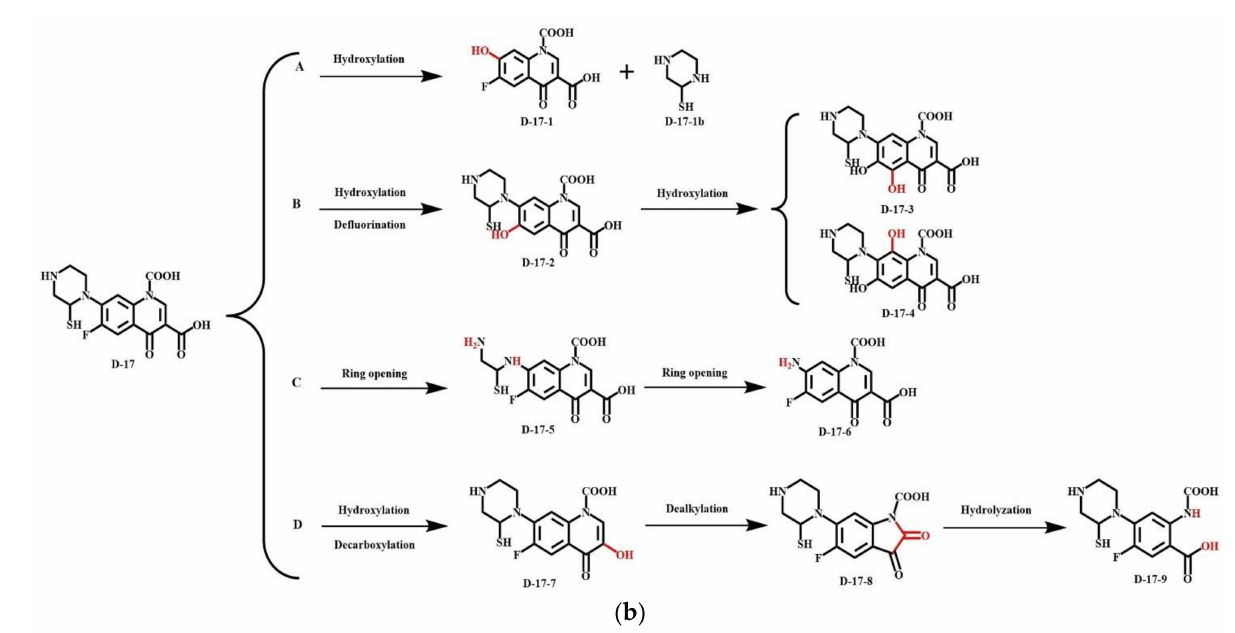
Figure 9. Simulation of the microbial degradation pathways of ( a ) NOR; and ( b ) its derivative